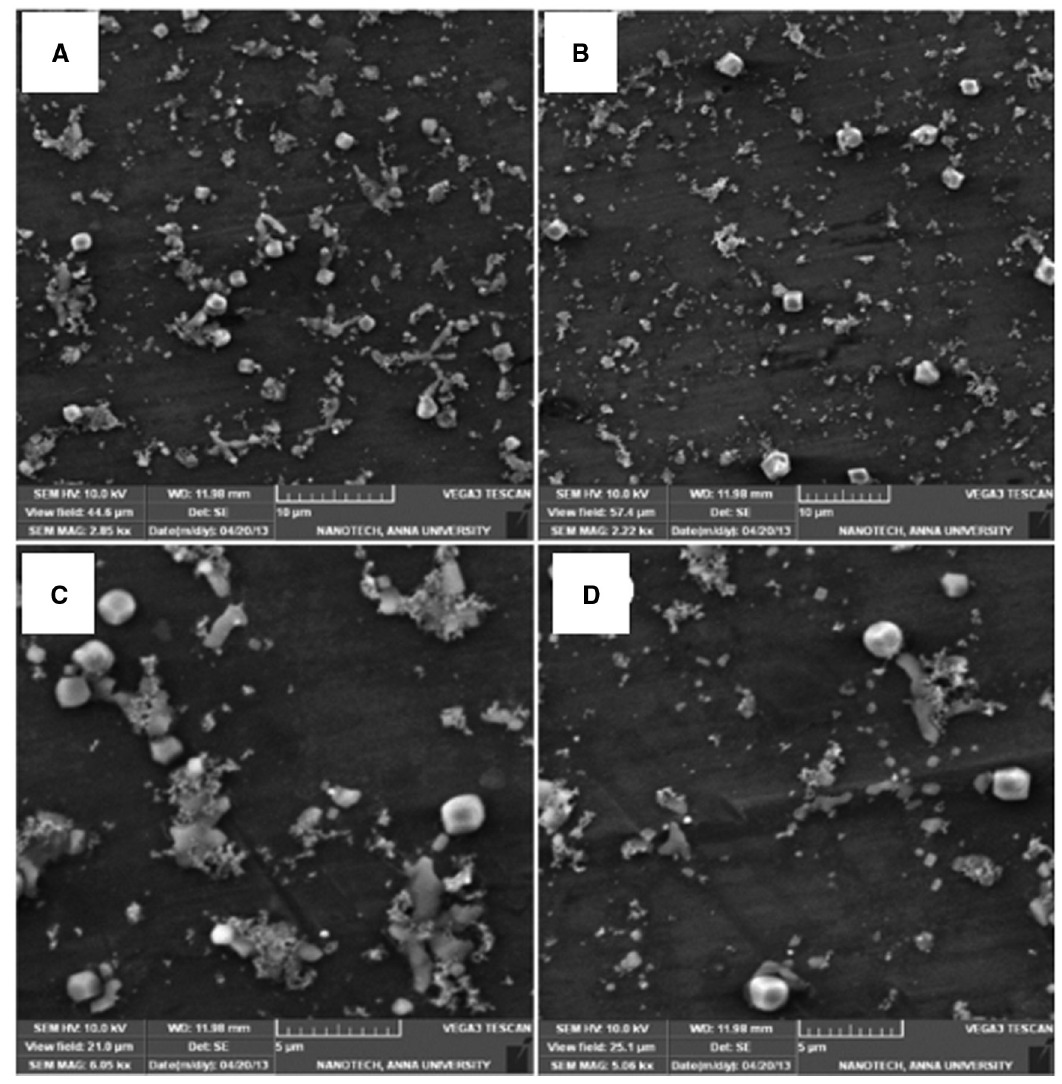
Figure 6 Scanning electron microscopy (SEM) images of gold nanoparticles at high and low resolution.